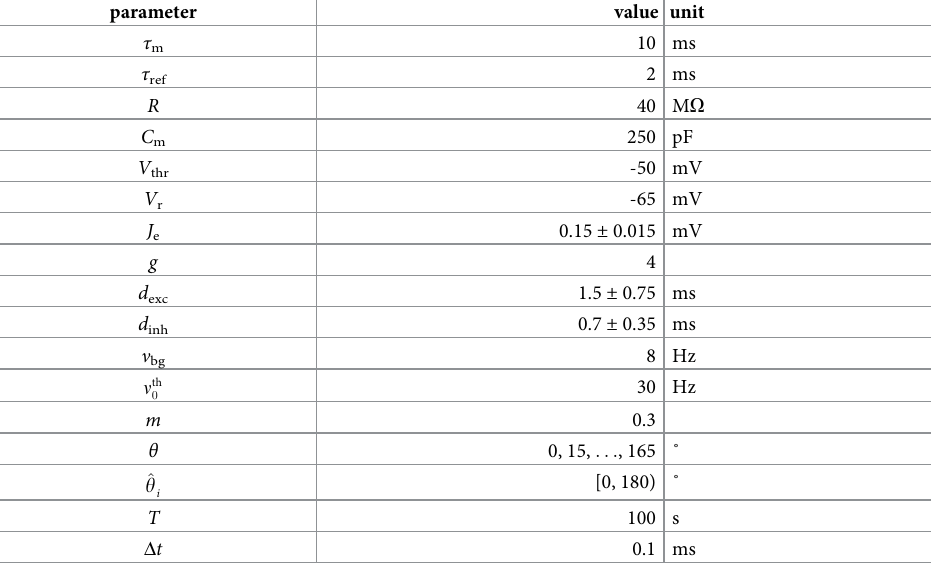
Table 2. Single neuron parameter